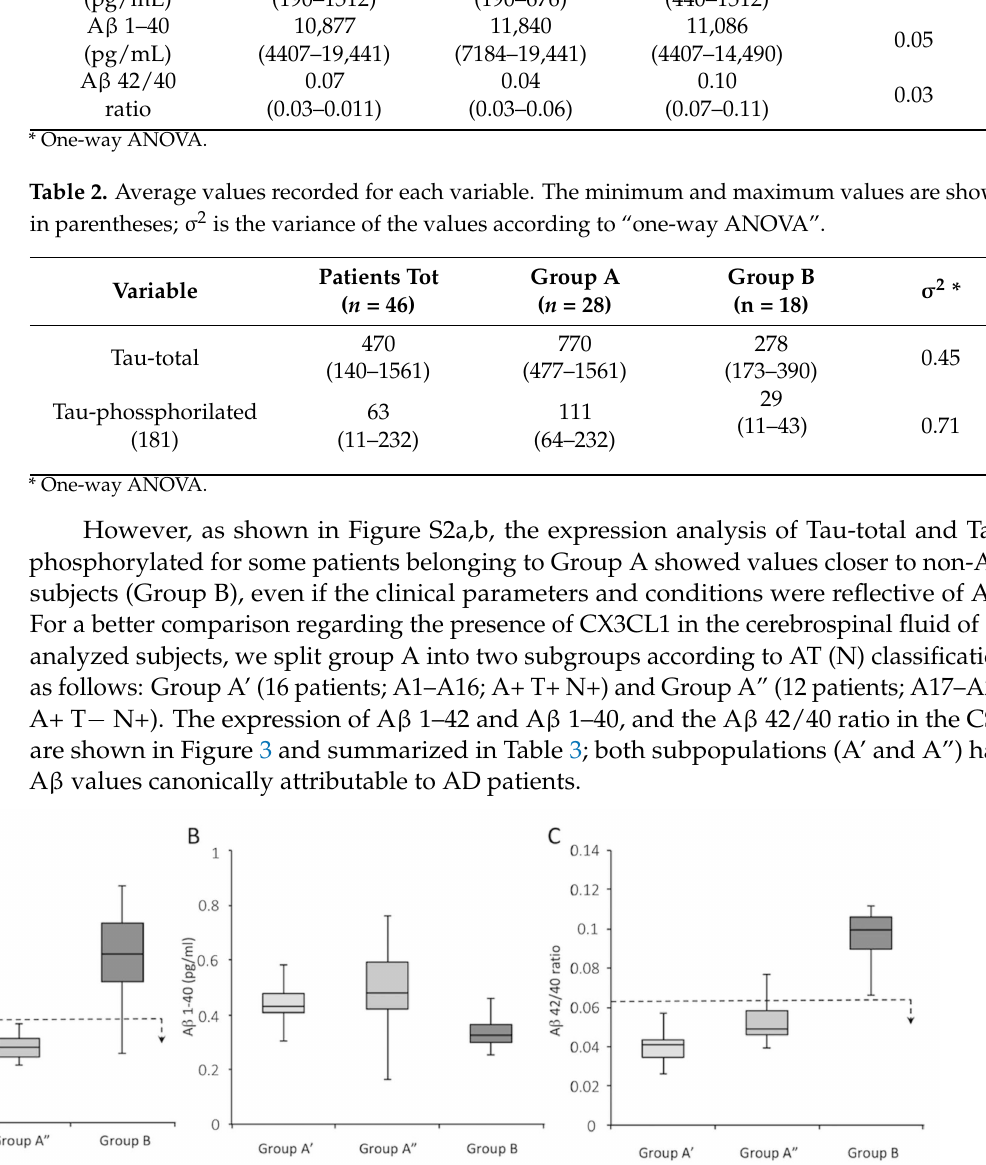
Figure 3. Subdivision of patients into Groups A’, A”, and B according to the expression of A β 1–42 ( A ) and A β 1–40 ( B ), and the A β 42/40 ratio ( C ). The dotted line represents the thresh- old for a subject to be considered AD or normal; the arrow indicates the direction of values for which the subjects are affected by AD. Group A’ is depicted in light gray, Group A” is depicted in medium gray, and Group B is depicted in dark